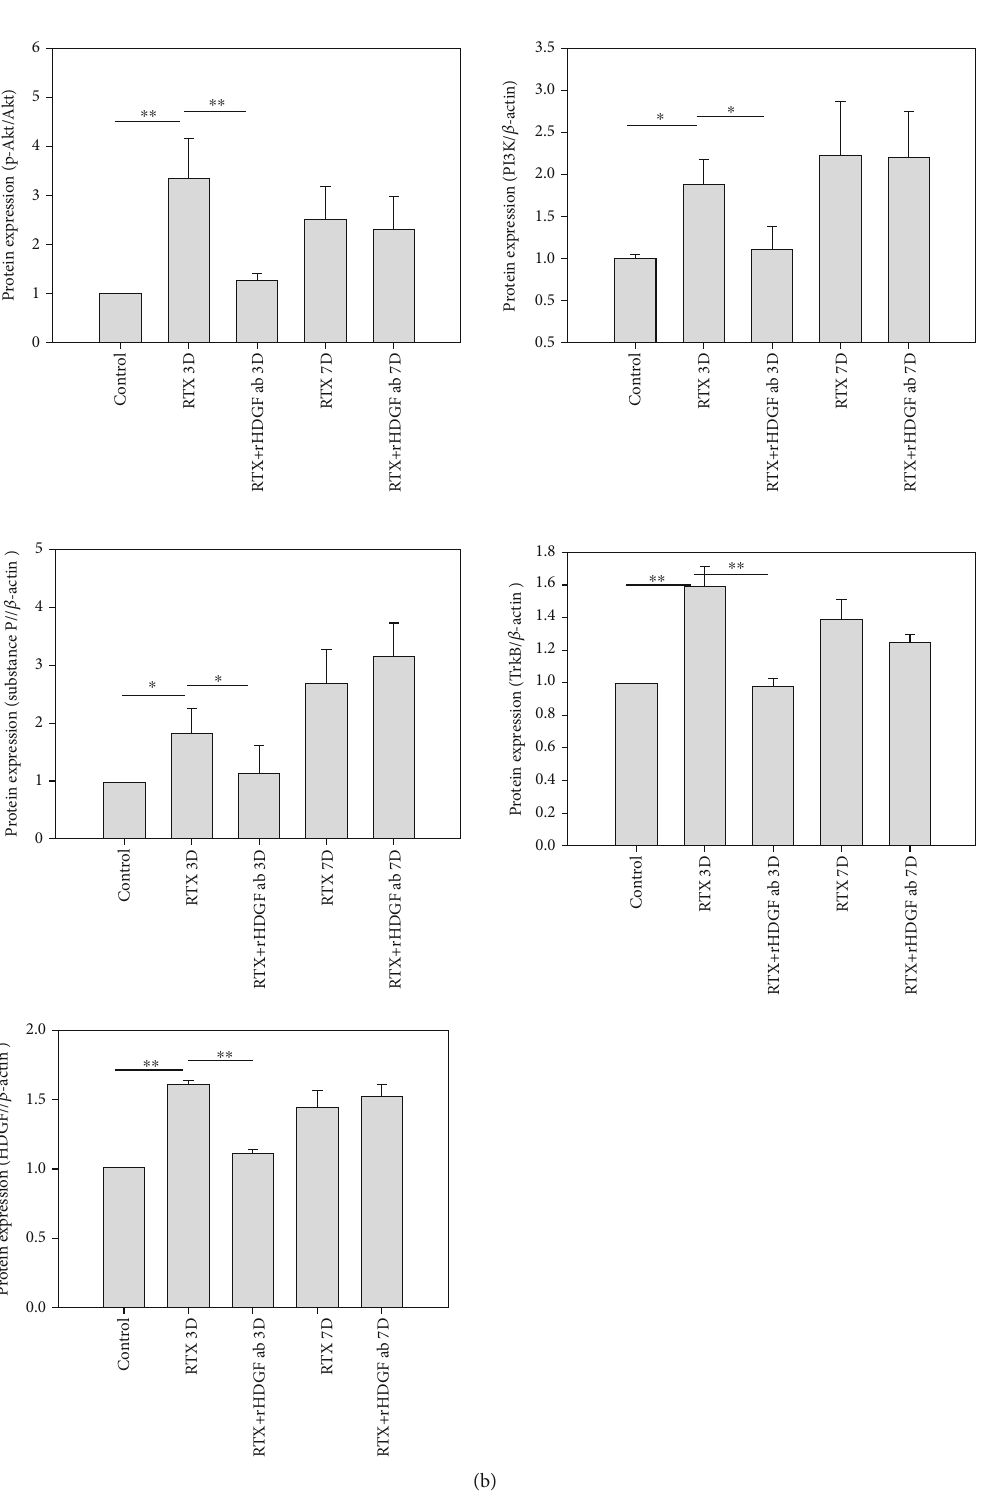
Figure 5: E ff ect of rHDGF antibody on expressions of HDGF, p-Akt/Akt, PI3K, substance P, and TrkB in the L3/L5 spinal cord dorsal horn of RTX-rats. After the rats were divided into three groups, neuropathy was induced by intraperitoneally administration of a single dose of RTX (50 μ g/kg). In the RTX+rHDGF antibody group, 100 μ g/kg rHDGF antibody was administered and applied 24 hours before RTX injection. The control group received no rHDGF antibody pretreatment and no RTX injection. At 3 or 7 days after RTX injection and/or pretreated with rHDGF antibody, L3-L5 spinal cord dorsal horn were harvested and protein expressions were measured through western blot analysis. (a) Representative Western blot results. (b) Expression levels were normalized to β -actin. ∗ P < 0 : 05 , ∗∗ P < 0 : 01 . Data are expressed as the mean + SEM ( n = 6 per